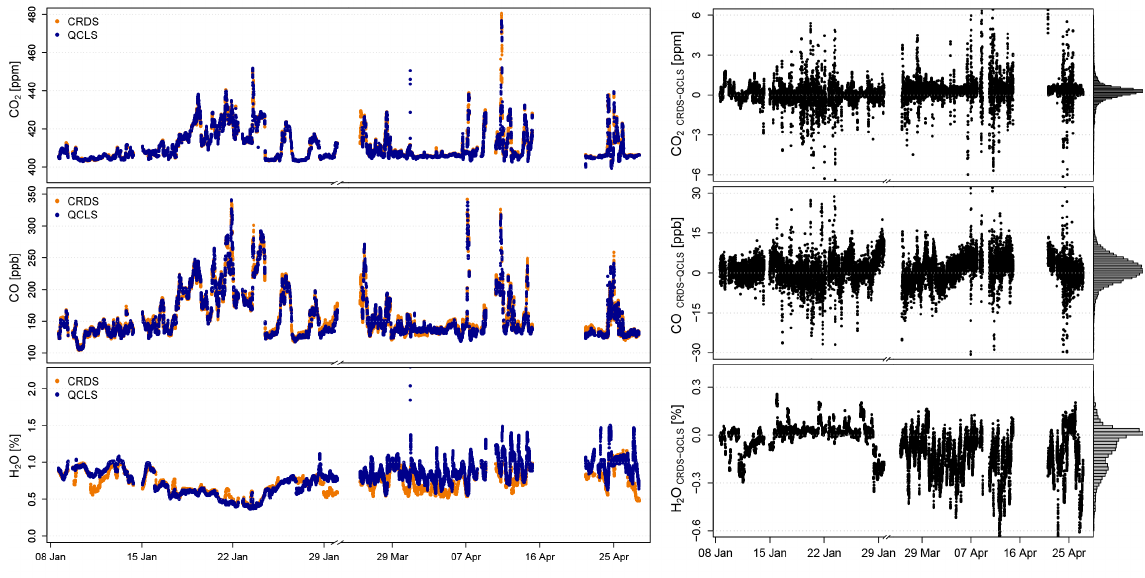
Figure 11. Minute-averaged measurements of CO 2 , CO and H 2 O from the Lutjewad measurement (60m) tower between 7 January and 29 April 2015 as measured by the QCLS (blue), compared with measurements from a CRDS (orange). The left plots show the time series and the right plots show the difference between CRDS and QCLS measurements together with the frequency distribution of the difference, which is plotted as a